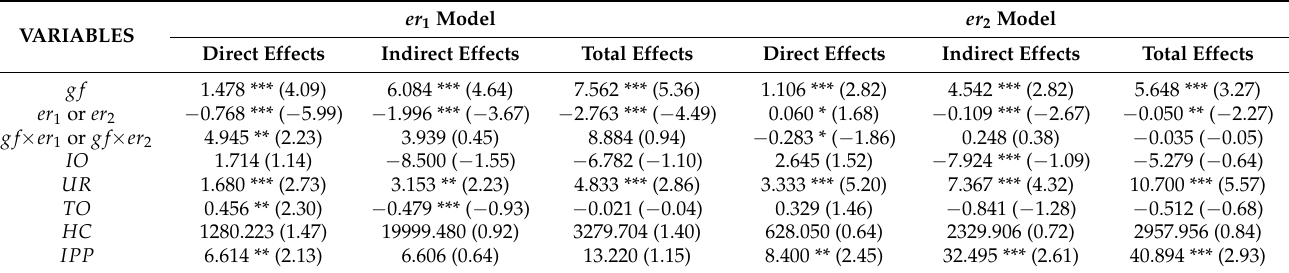
Table 7. Spatial spillover effects of er 1 model and er 2 model under w 1 weight